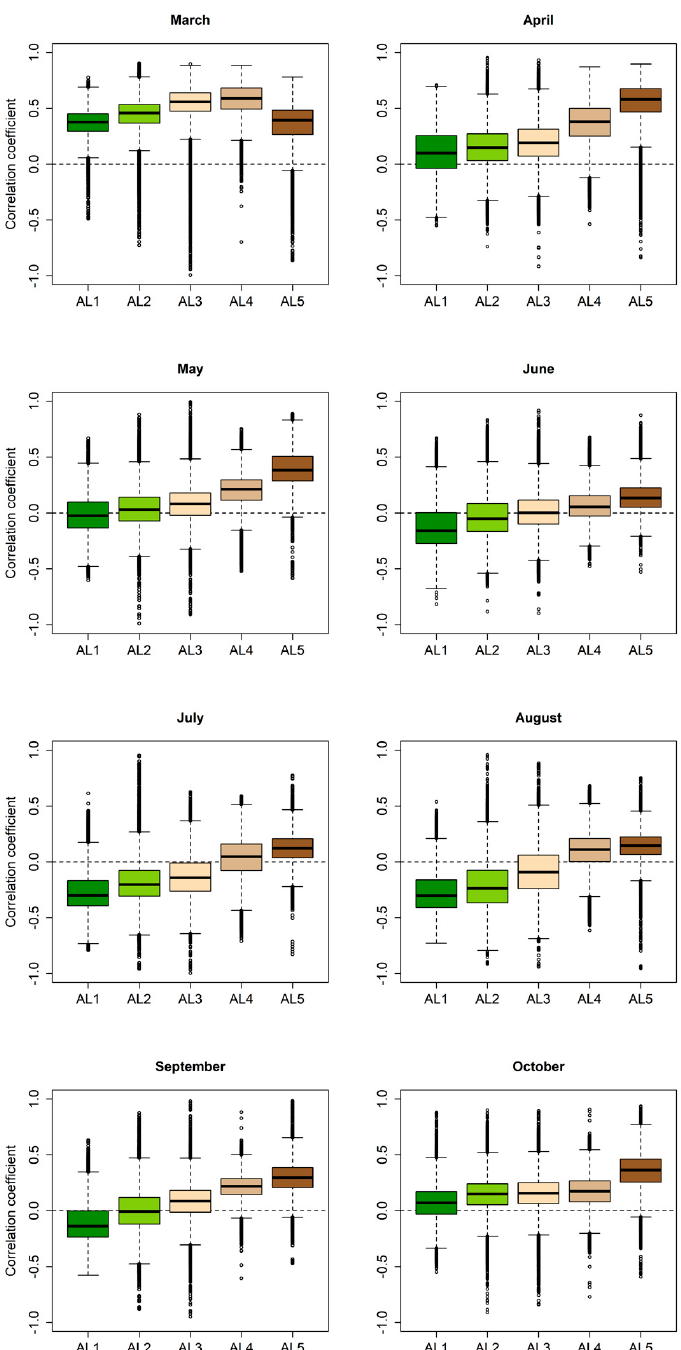
Figure 5. Pixel-based monthly correlation coefficients (Bravais-Pearson) between 8-day NDVI and LST by altitude levels in Bavaria from 2001 to 2020. Altitude levels (Table 2) are <300 m (AL1),